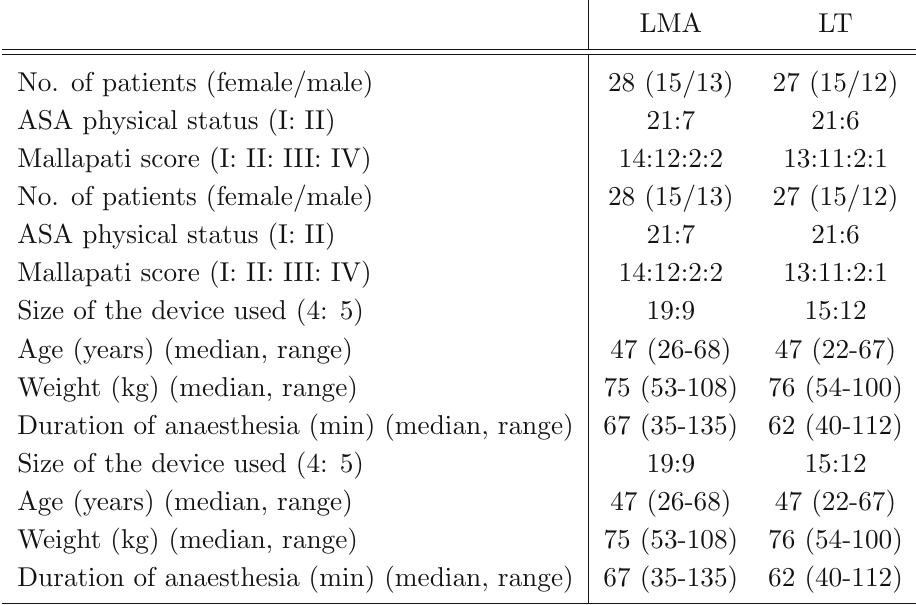
ventilated by laryngeal mask airway (LMA) or laryngeal tube (LT).